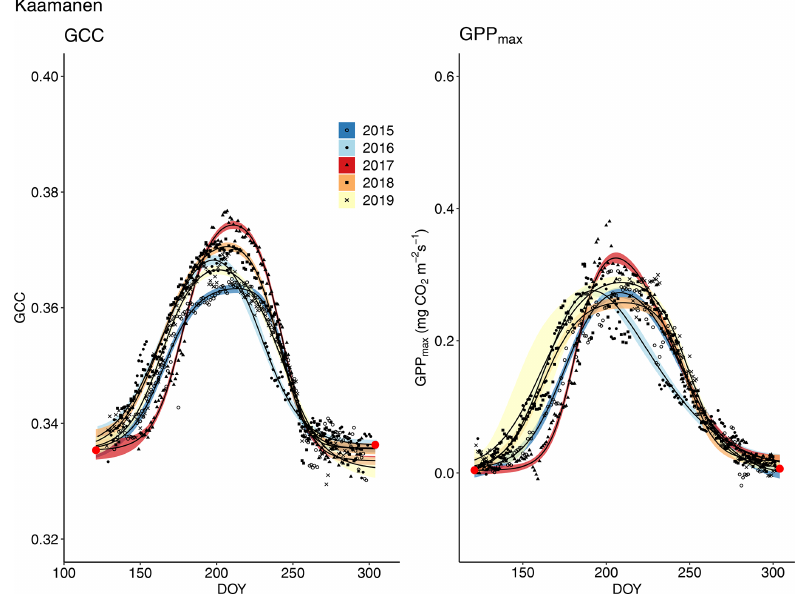
Figure 9. Development of GCC and GPP max from 1 May to 30 September in 2015–2019 at Kaamanen. Different symbols and colours denote different years, and the bands show the 95% confidence intervals of the fitted double hyperbolic tangent function. The red dots indicate the fixed start and end days defined for the